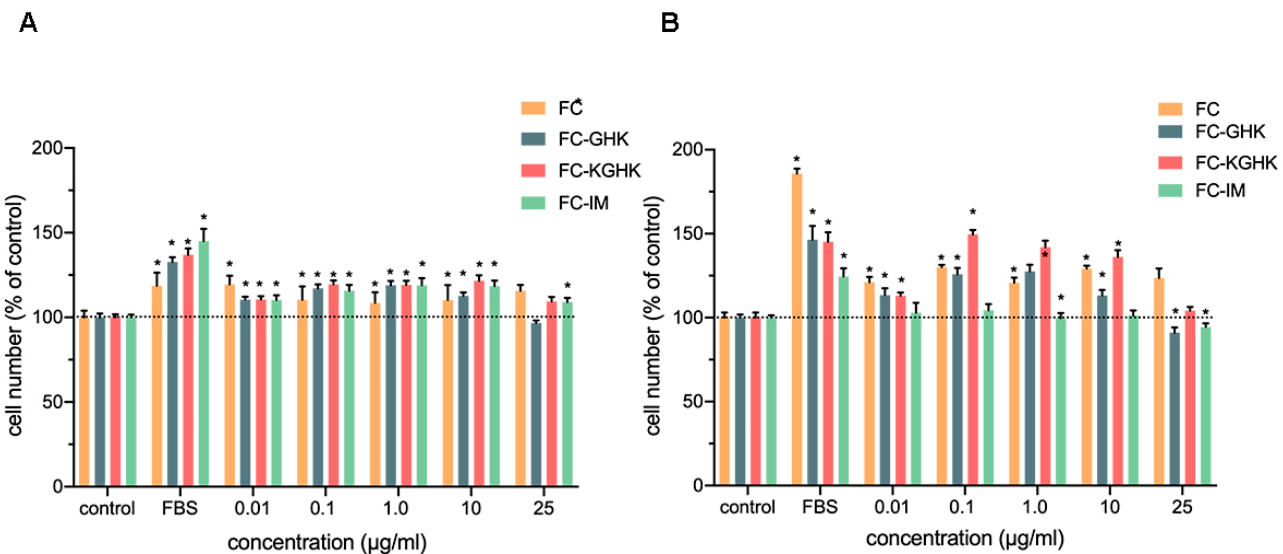
Figure 9. Peptide effect on proliferation of 46BR.1N fibroblasts after ( A ) 48 h and ( B ) 72 h incubation. The graphs show results from four independent experiments (four replicates in each, n = 16). Results are presented as mean with SEM. *- statistically significant differences compared to control, Mann-Whitney U test, p < 0.05. FBS-positive control cells grown in a medium containing 10% FBS.